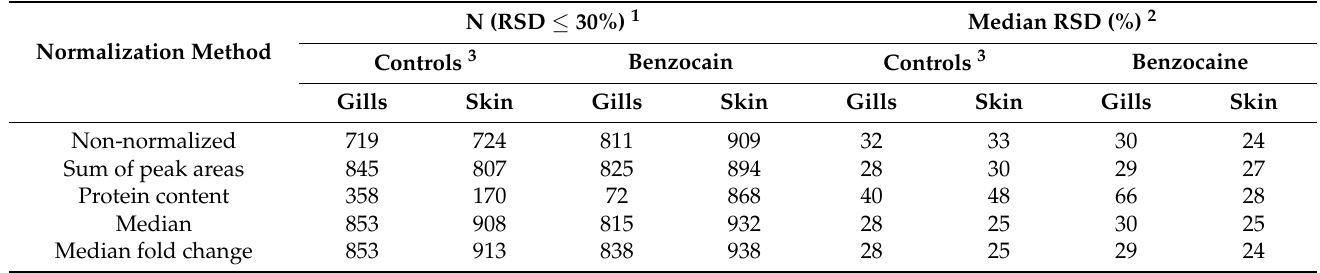
Table 1. The number of metabolites with an intra-group variation RSD ≤ 30% from untargeted HILIC–HRMS.